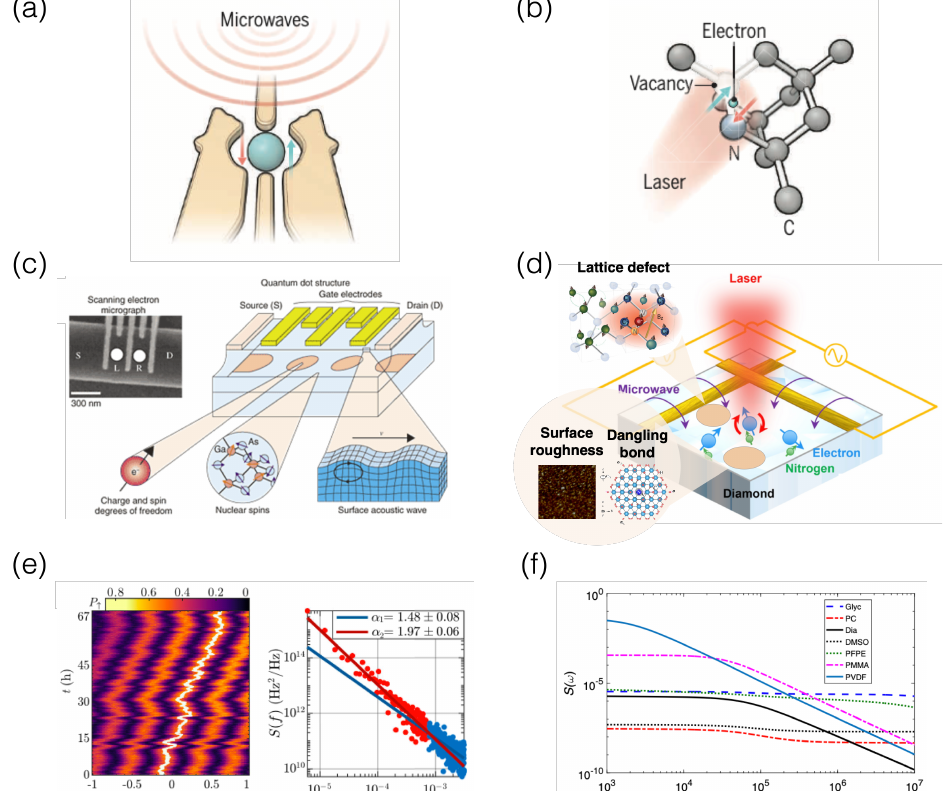
Figure 5. Illustration of two semiconductor spin-qubit forerunners with typical controlled schemes: ( a ) a gate-defined quantum dot (QD) with microwave and ( b ) a nitrogen-vacancy (NV) center in diamond with laser. Images are from https://www.science.org/content/article/scientists-are- close-building-quantum-computer-can-beat-conventional-one, accessed on 20 August 2022 (pub- lic domain). ( c , d ) Sketch of known noise sources in QD and NV center devices, respectively. Image of ( c ) is reproduced from Ref. [115]; ©2008 Nippon Telegraph and Telephone Corpora- tion. Image of ( d ) is from https://www.eurekalert.org/multimedia/943791 (public domain) and http://qeg.mit.edu/research.php, accessed on 20 August 2022 (public domain), adapted with permis- sion from Ref. [116]; ©2021 American Physical Society. ( e ) (Left) Time evolution of the probability to be in the spin-up state over 67 h for the microwave resonance frequency detuning parameter ∆ f MW . (Right) Power spectral density of the qubit detuning with two separate 1/ f α power-law regions of exponents α 1 = 1.48 (blue) and α 2 = 1.97 (red). Images are adapted with permission from Ref. [117]; ©2020 Springer Nature Limited. ( f ) Comparisons of power spectral densities of NV centers in six different protective materials and their influence on noise processes, adapted with permission from Ref. [118]; ©2018 American Physical